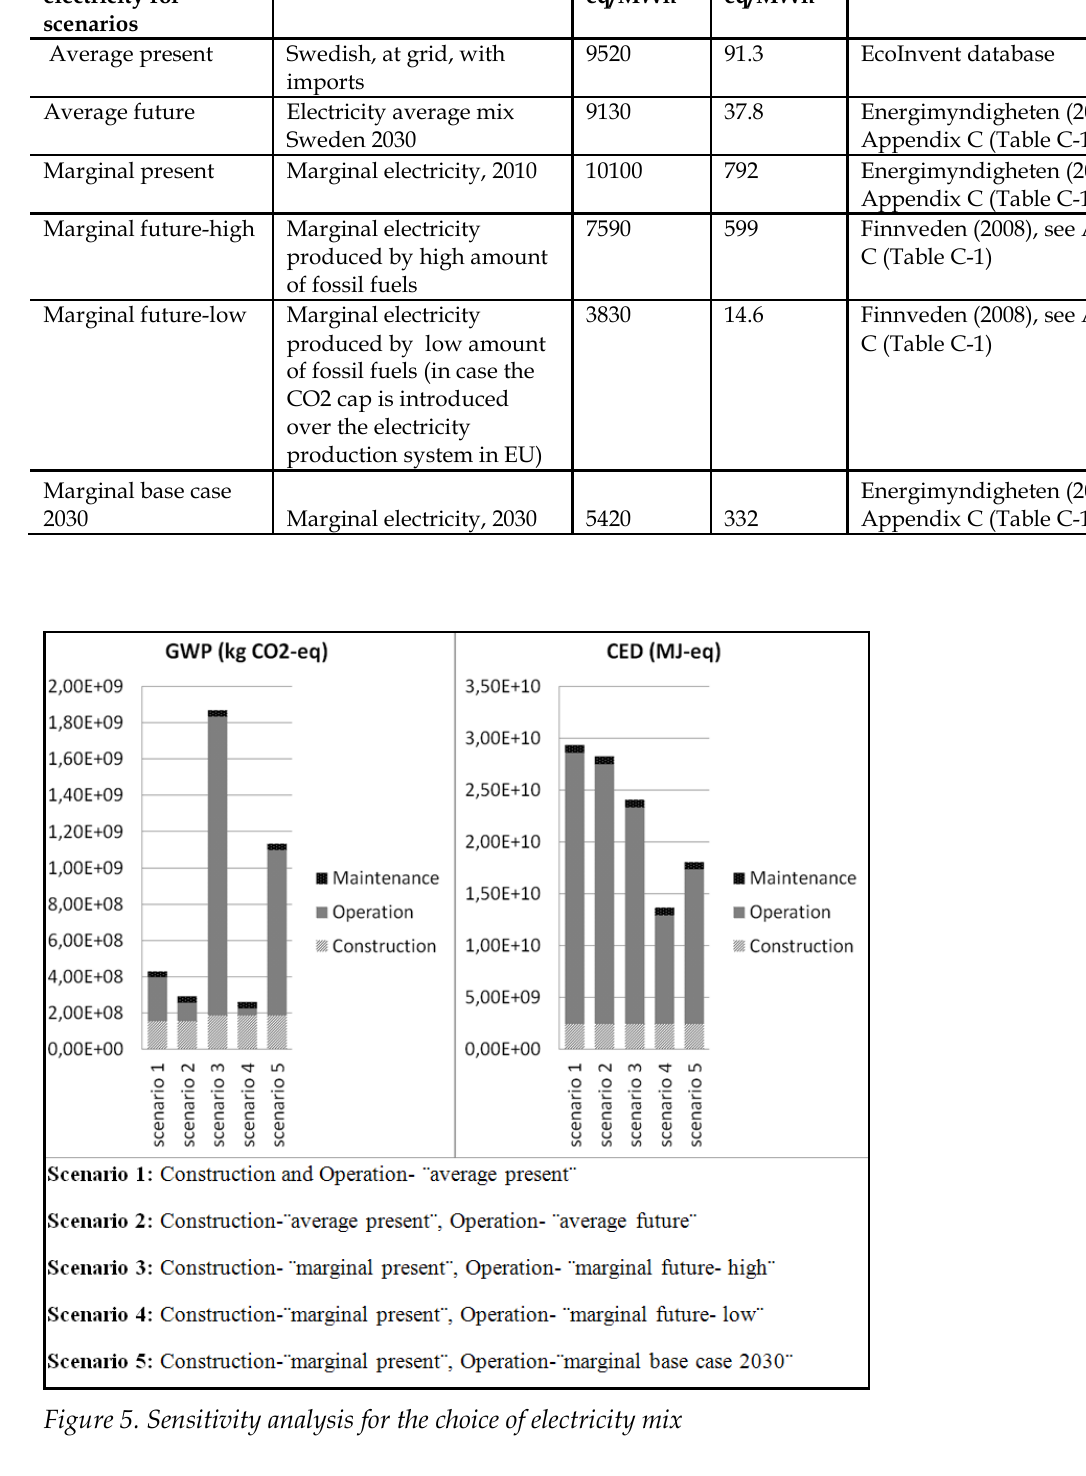
Table 5. Types of electricity chosen for sensitivity analysis Description of